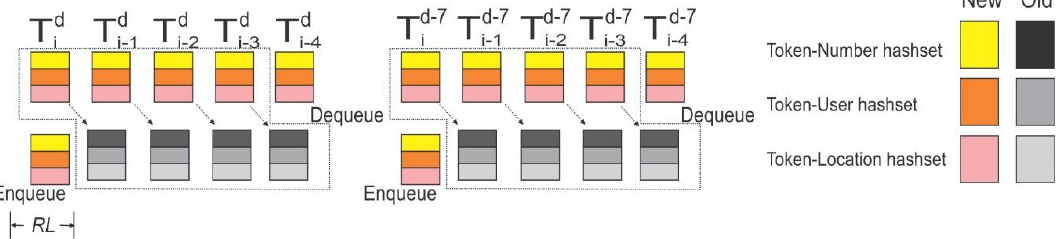
Figure 2. Two queue structures to store three hash sets. Enqueue and dequeue happen at the beginning of each hour. Superscript represents day unit while subscript represents hour unit. RL represents the reference layer.